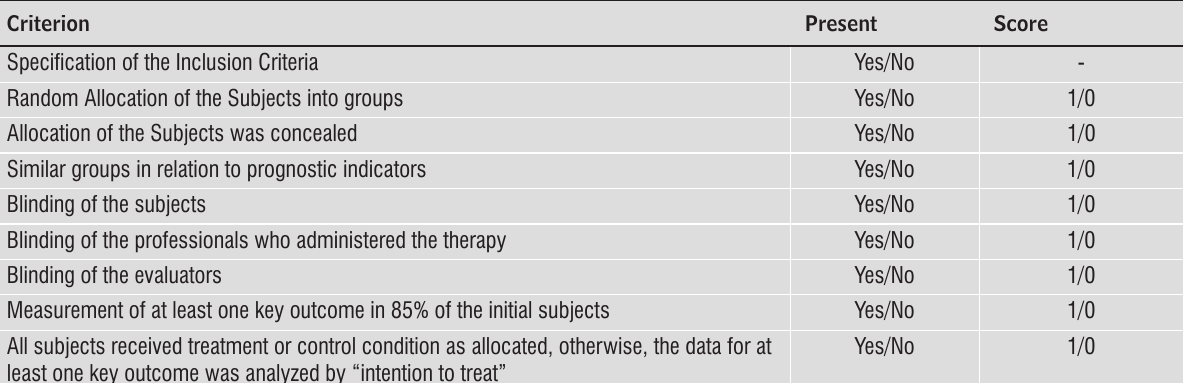
Table 1 - PEDro scale of Methodological Classification Criterion Speci fi cation of the Inclusion Criteria Random Allocation of the Subjects into groups Allocation of the Subjects was concealed Similar groups in relation to prognostic indicators Blinding of the subjects Yes/No Blinding of the professionals who administered the therapy Blinding of the